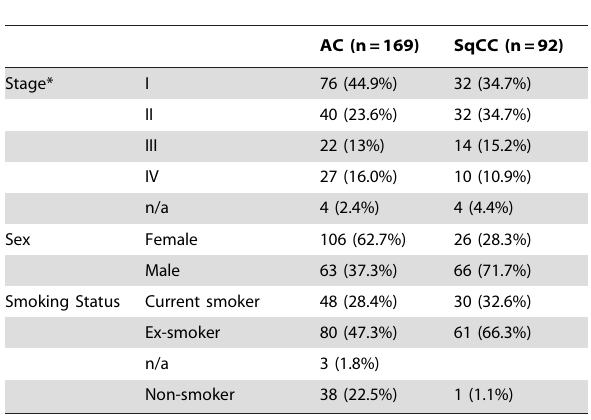
Table 1. Sample set clinical